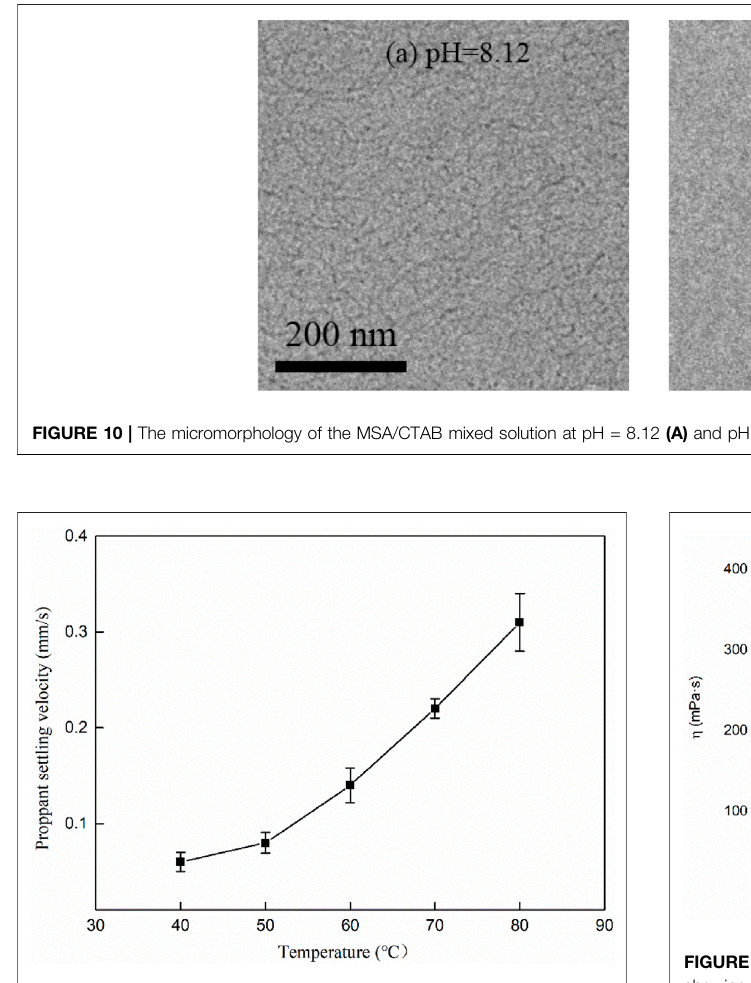
Frontiers in Chemistry |